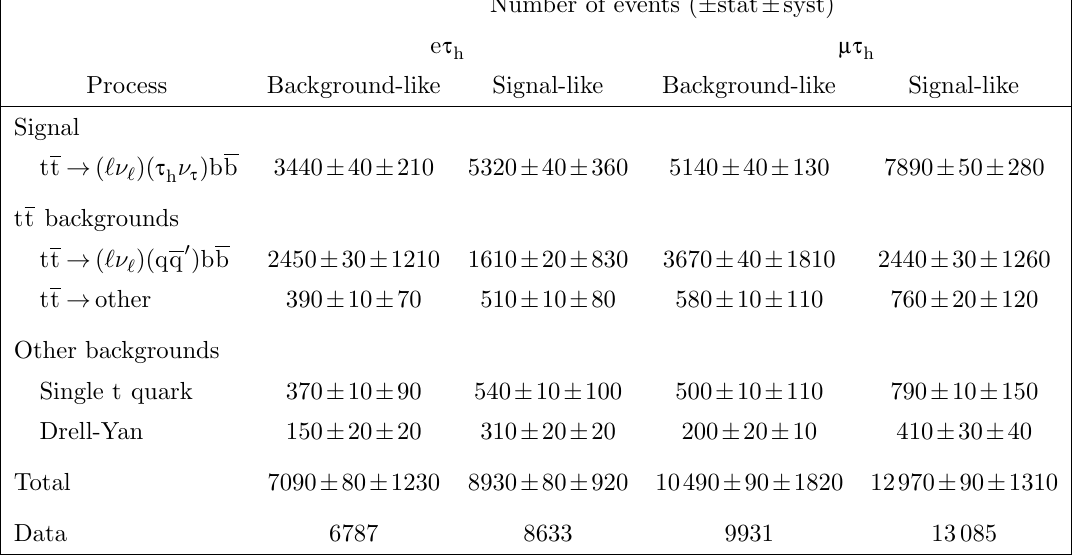
Table 1. Expected and observed event yields in the ‘ t ( ‘ = e ; m ) (cid:12)nal state for signal and h background processes for an integrated luminosity of 35.9 fb (cid:0) 1 . Statistical and systematic uncer- tainties are shown. The expected pre(cid:12)t contributions of all processes are presented separately for background-like and signal-like event categories. The statistical uncertainties of the modelling are shown for the processes estimated from the simulation. The multijet contribution and the corre- sponding statistical uncertainties are estimated using data, as described in section